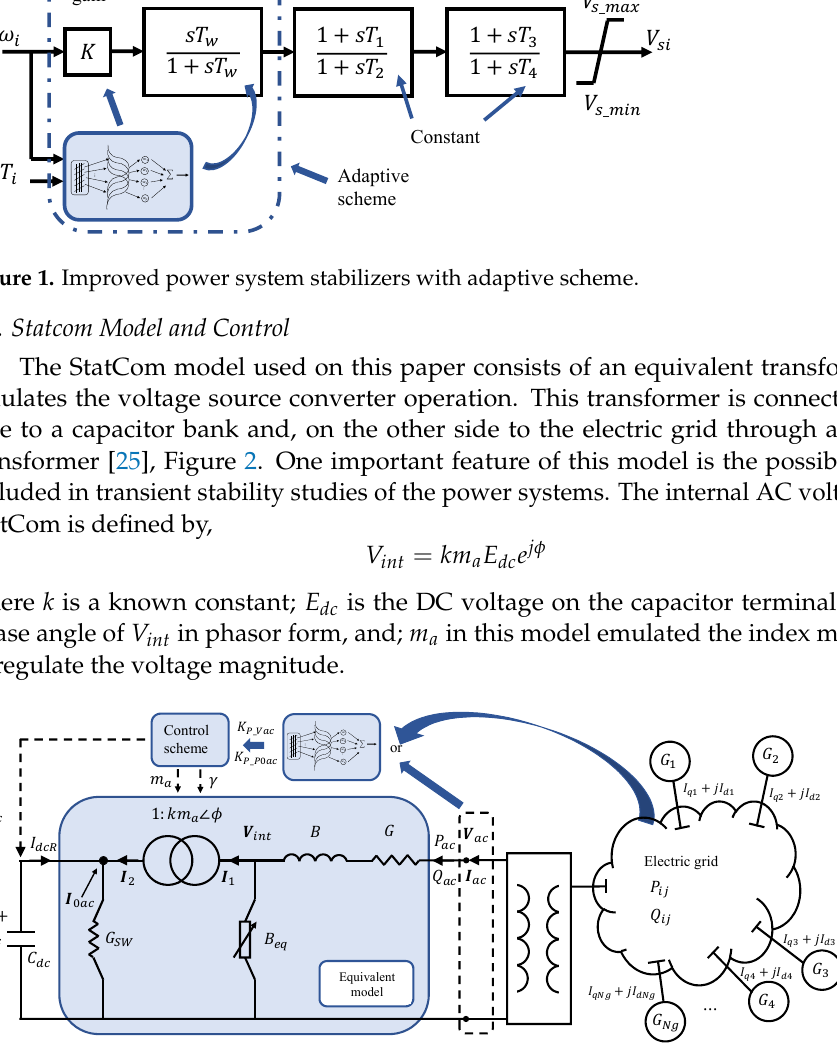
Figure 2. StatCom model with dynamic control